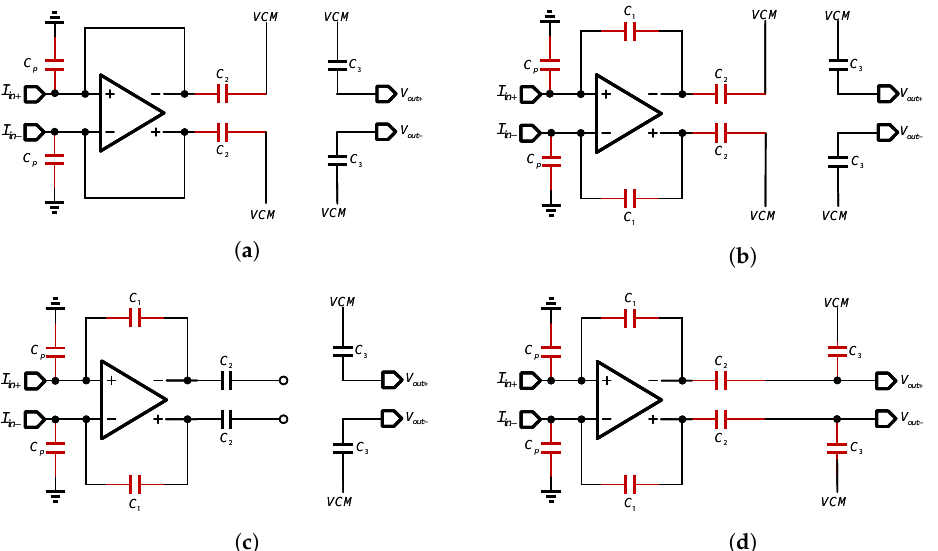
Figure 9. The different working states of the TIA. ( a ) The working state when t 1 < t < t 2 ; ( b ) The working state when t 2 < t < t 3 ; ( c ) The working state when t 3 < t < t 4 ; ( d ) The working state when t 4 < t < t 5